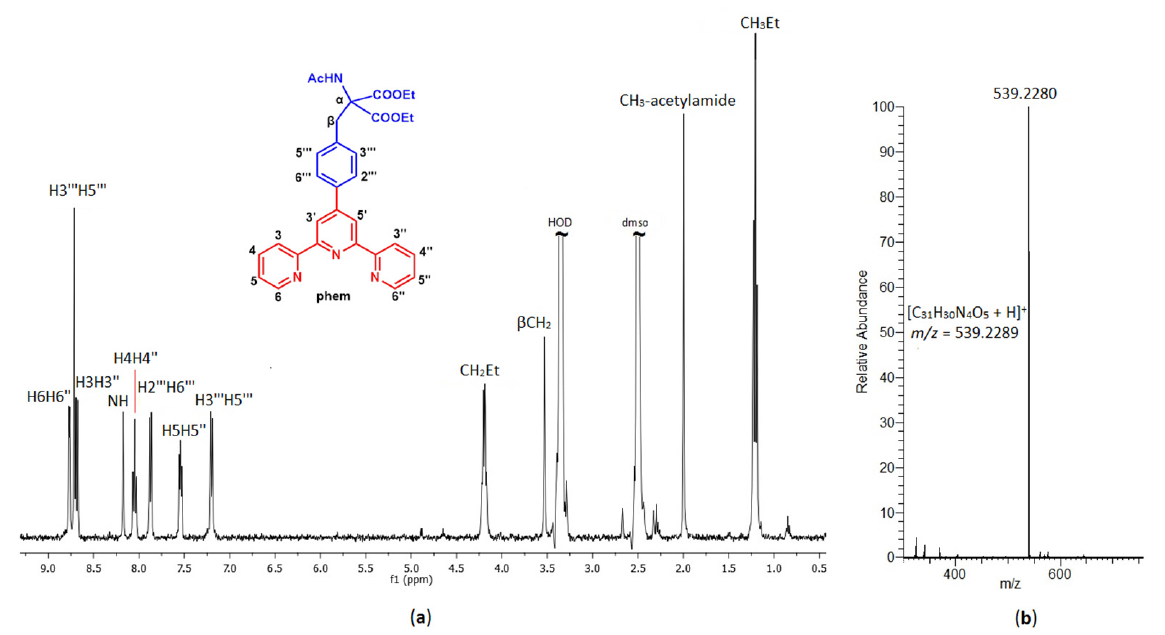
Figure 1. ( a ) The 1 H NMR spectrum (dmso-d 6 , 298 K, δ ppm) of phem with structure numbering and proton assignments. ( b ) The HR-ESI-MS of phem.